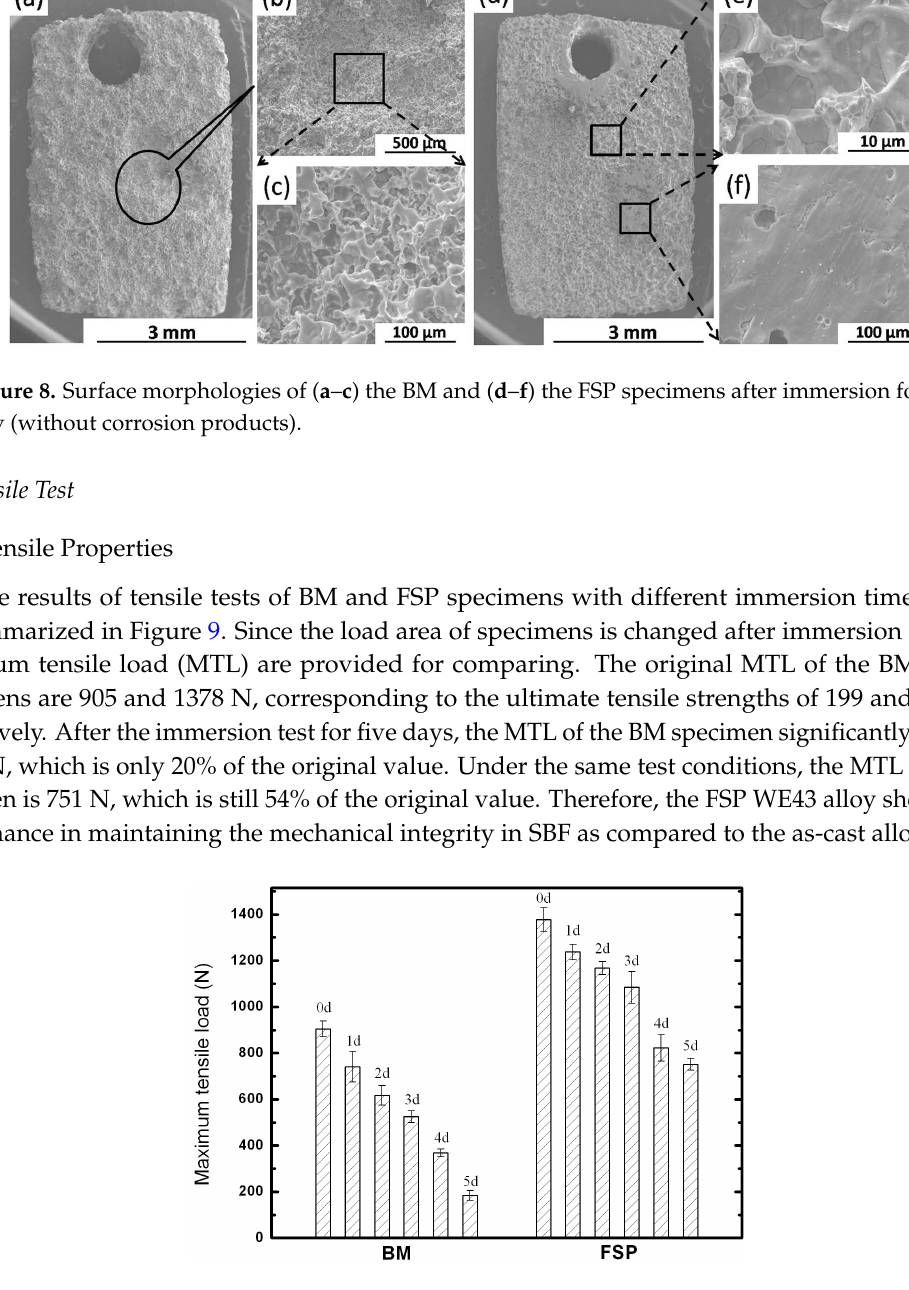
Figure 9. Tensile properties of the BM and FSP specimens after different immersion time intervals.